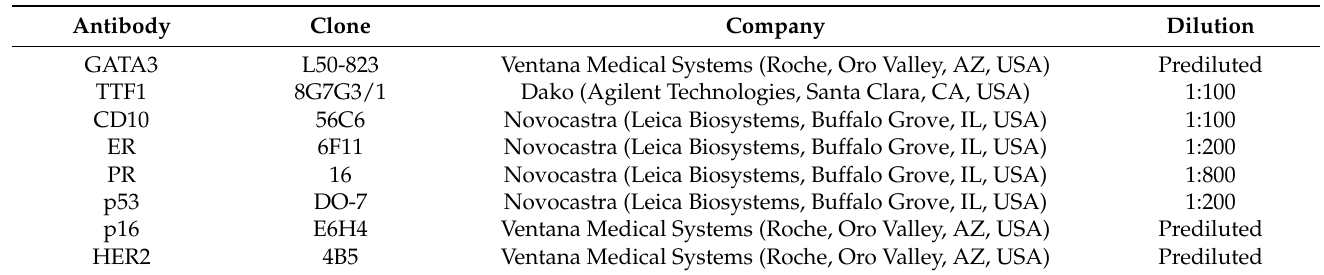
Figure 1. Histological features of uterine MLA: architectural diversity. The classic morphological pattern of uterine MLA is tubular, with small, compactly aggregated tubules containing densely eosinophilic intraluminal secretions. Additional morphological patterns are maze-like, cribriform, ductal (endometrioid), papillary, solid, sex cord-like, etc. Such architectural diversity poses a challenge in the differential diagnosis of uterine MLA and the more common histological subtypes of endometrial carcinomas, including EC and SC. Table 1. Antibodies